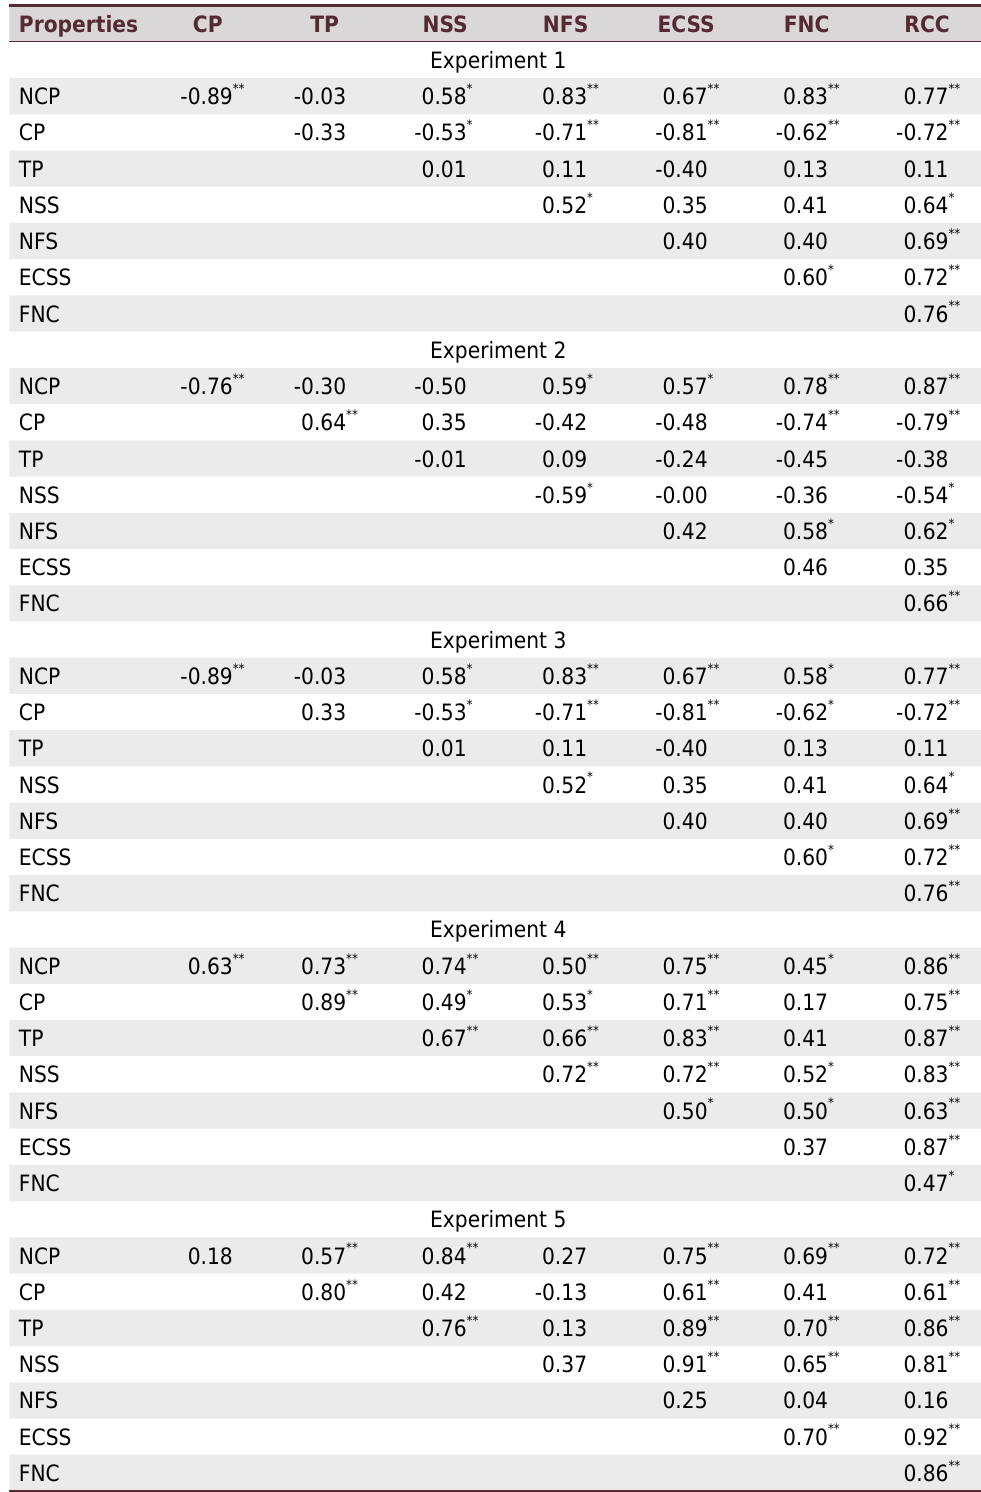
Table 2. Correlation coefficient matrix (Pearson) among the properties of non-commercial production (NC), commercial production (CP), total production (TP), nitrate in soil solution (NSS), nitrate in the foliar sap (NFS), electrical conductivity of the soil solution (ECSS), foliar nitrogen content (FNC), relative chlorophyll content (RCC) in five experiments with increasing doses of nitrogen in the crop of garlic in two growing seasons